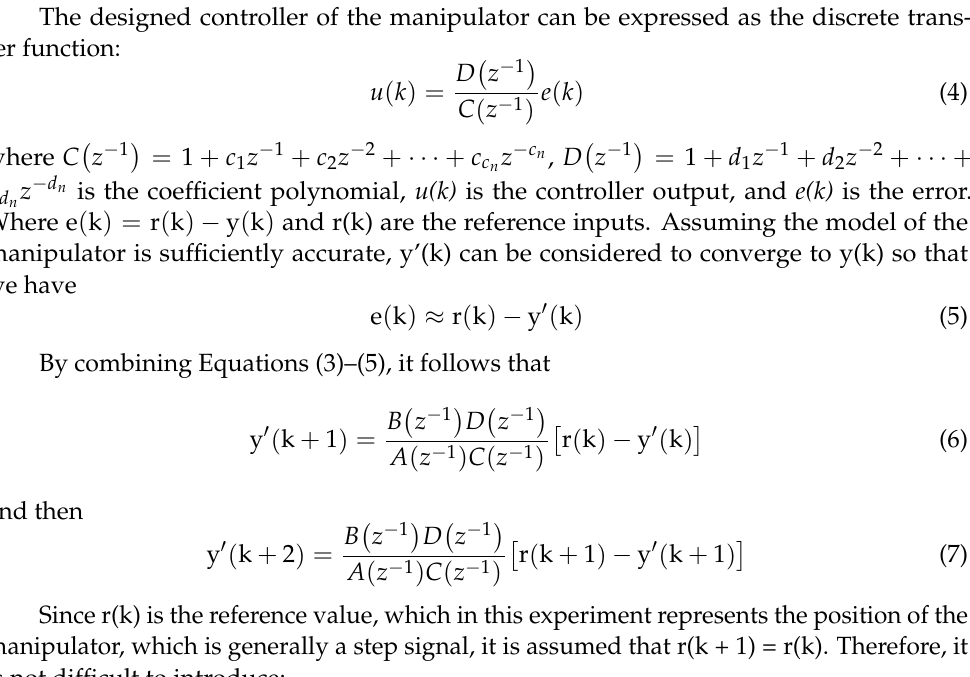
Figure 11. Video monitoring scheme and network delay